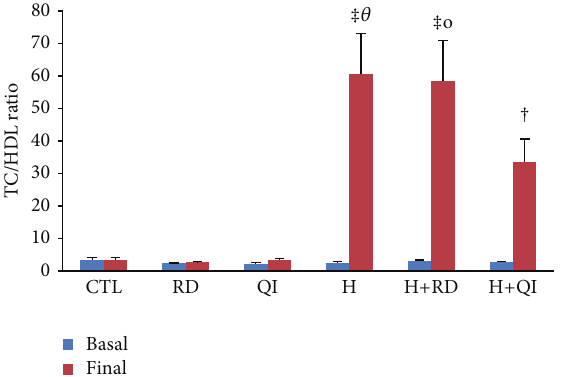
Figure 2: The basal and final values of plasma atherogenic index (LDL/HDL ratio) of the animal groups. The values are Mean ± SEM. 𝑛 = 6 , CTL: control; RD: Rosa damascena L.; QI: Quercus infectoria ; H: Hyperlipidemic; H+RD: Hyperlipidemic+RD; H+QI: Hyperlipidemic+QI. ‡ 𝑃 < 0.001 compared with the related basal value; o 𝑃 < 0.001 compared with the final values of CTL, RD, and QI groups; 𝜃 𝑃 < 0.001 compared with the final values of the RD and CTL; ‡ 𝑃 < 0.01 compared with the final values of the CTL and QI